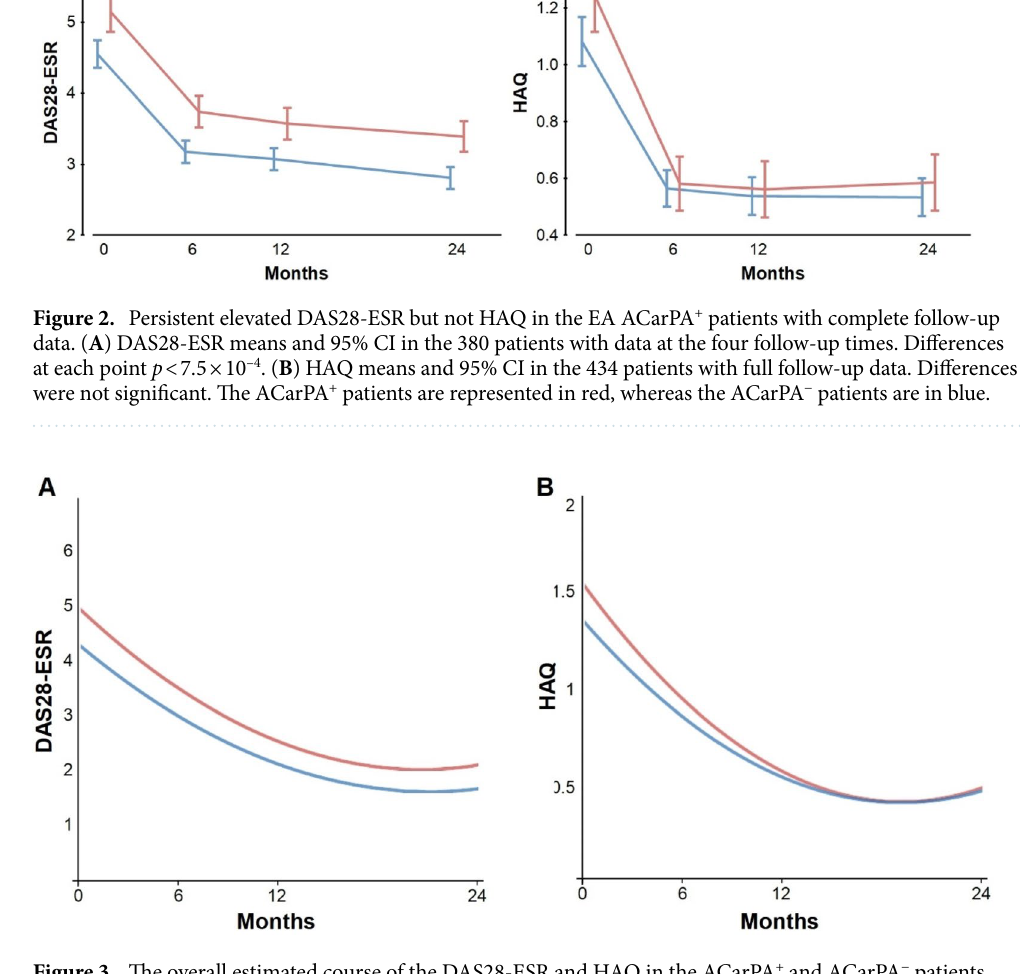
(Fig. 3). On the one hand, there was a persistent increase in the DAS28-ESR along the study (Fig. 3A). On the other hand, there was a loss of the initial HAQ difference with time (Fig. 3B). However, in contrast to the visit-